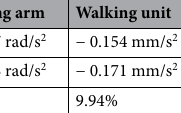
Table 6. Comparison between simulated values (average values) and experimental values (average values) of vibration displacement.